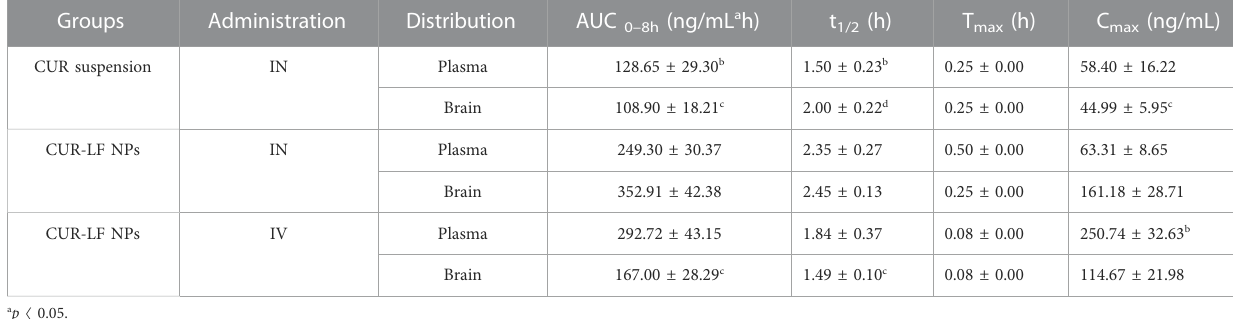
TABLE 2 The plasma and brain pharmacokinetic parameters after intranasal administration of curcumin suspension and CUR-LF NPs, and intravenous administration of CUR-LF NPs at a dose of 10 mg/kg. Data were presented as mean ± SD (n = 3).